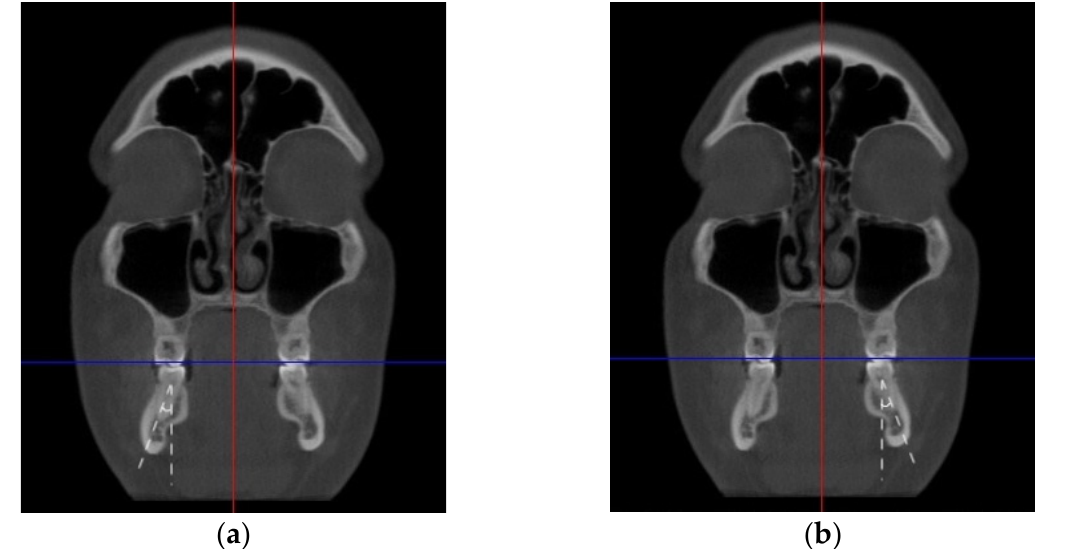
Figure 2. Measurement of mandibular right ( a ) and left ( b ) alveolar bone inclination. The angle between line connecting the midpoint of the alveolar crest and the midpoint of the buccolingual width at 1/3 the distance from the inferior border of the mandible and vertical line was measured.